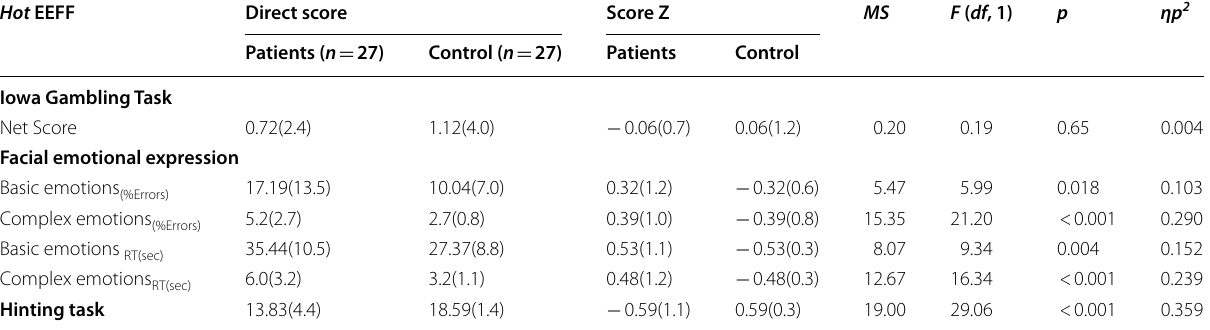
CI for difference. RT